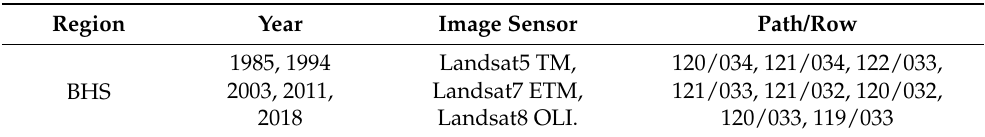
Figure 1. Location ( a ), bathymetry ( b ), T/P crossover points ( c ), and land – sea grid construction ( d ) of the study area in 2018. Table 1. List of land satellite image data of the